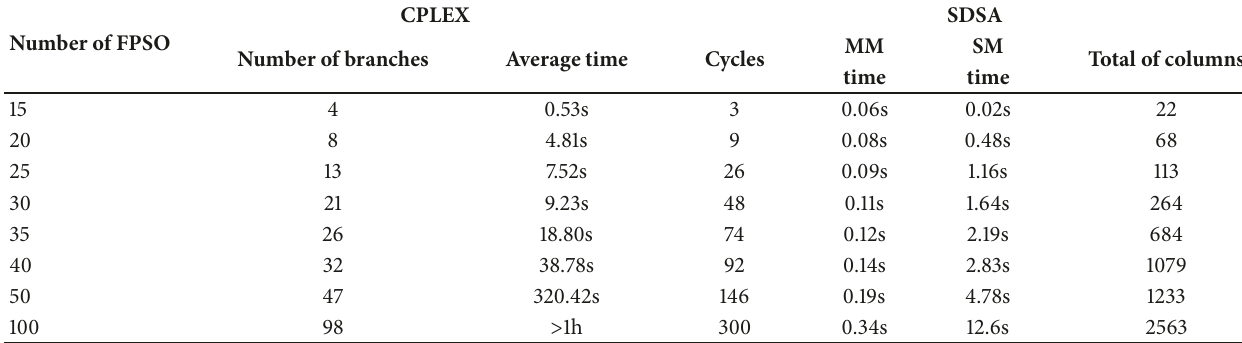
Table 2: Information of algorithm substep efficiency.